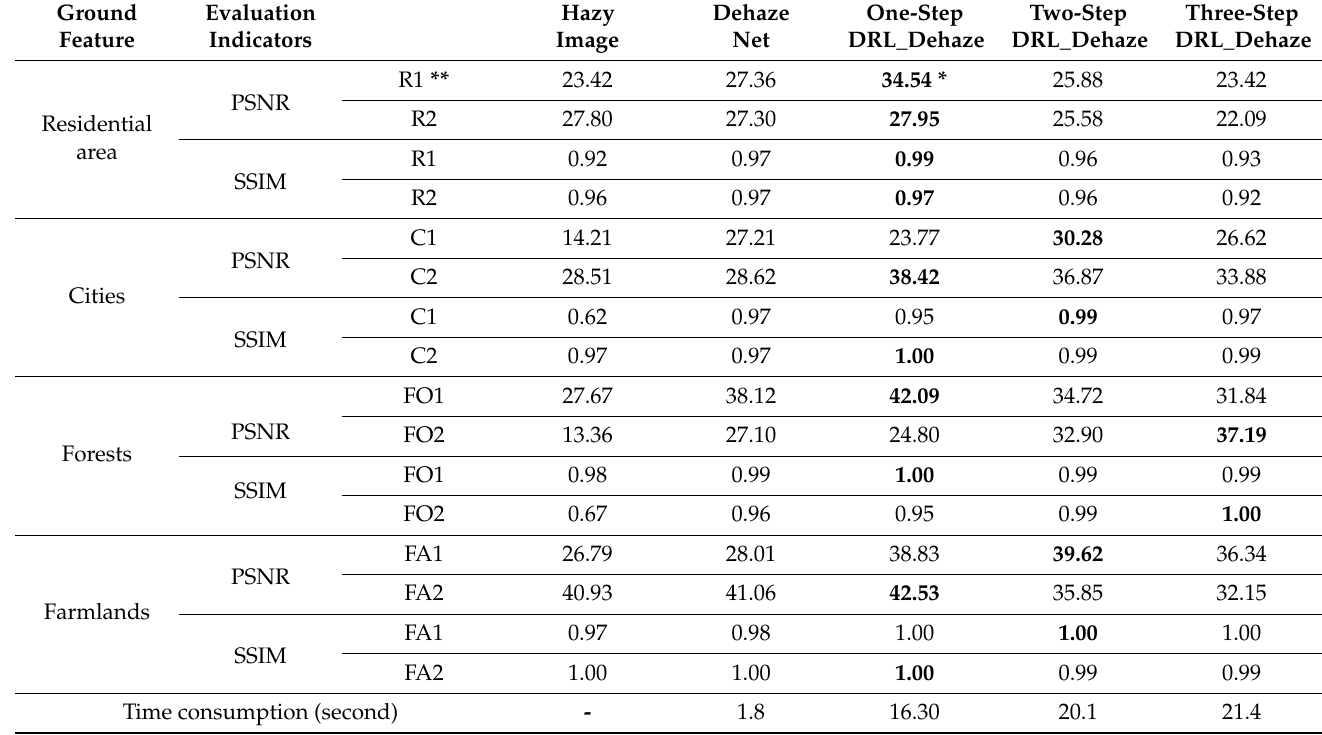
Table 4. Quantitative evaluation results of DehazeNet methods and the DRL_Dehaze methods. Ground